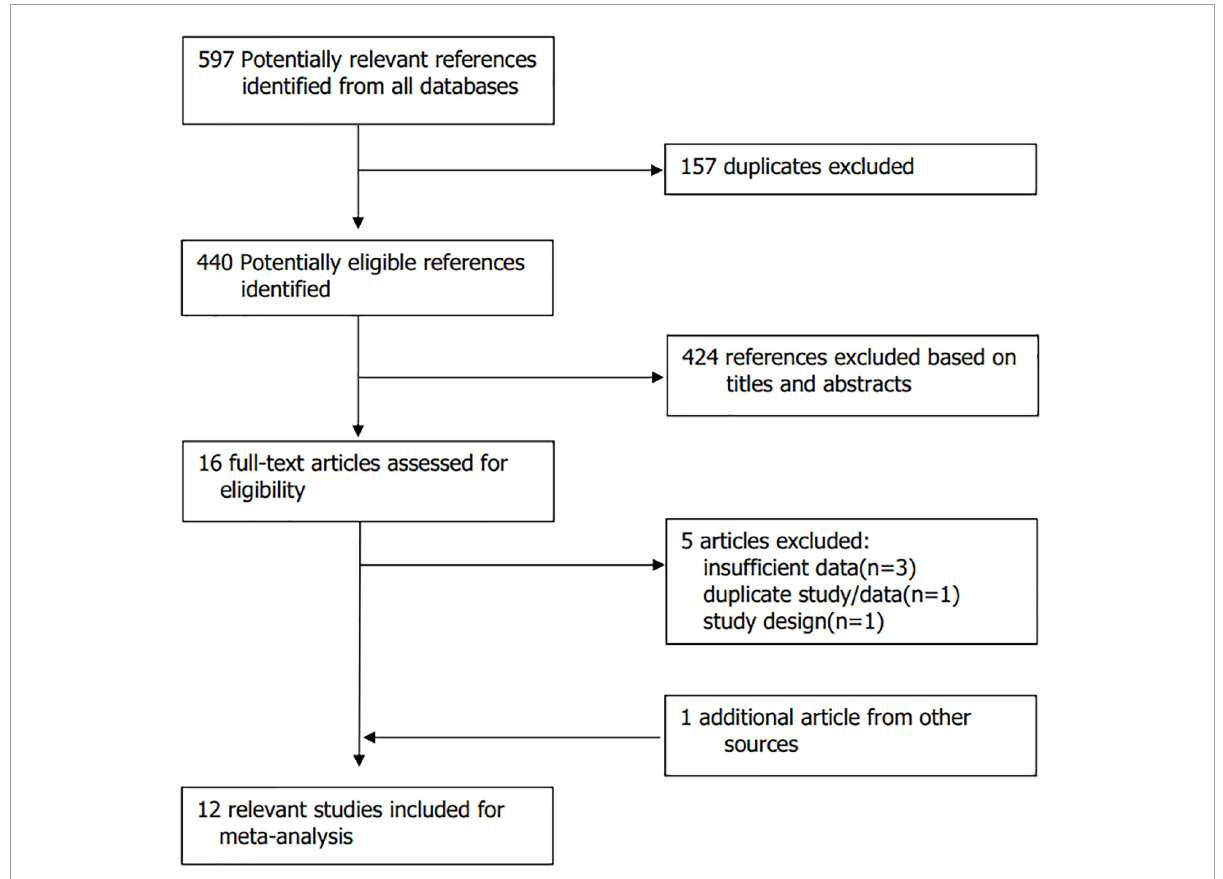
FIGURE1 Flow chart. A total of 12 studies were included finally. Reason for exclusion of possibly eligible studies are